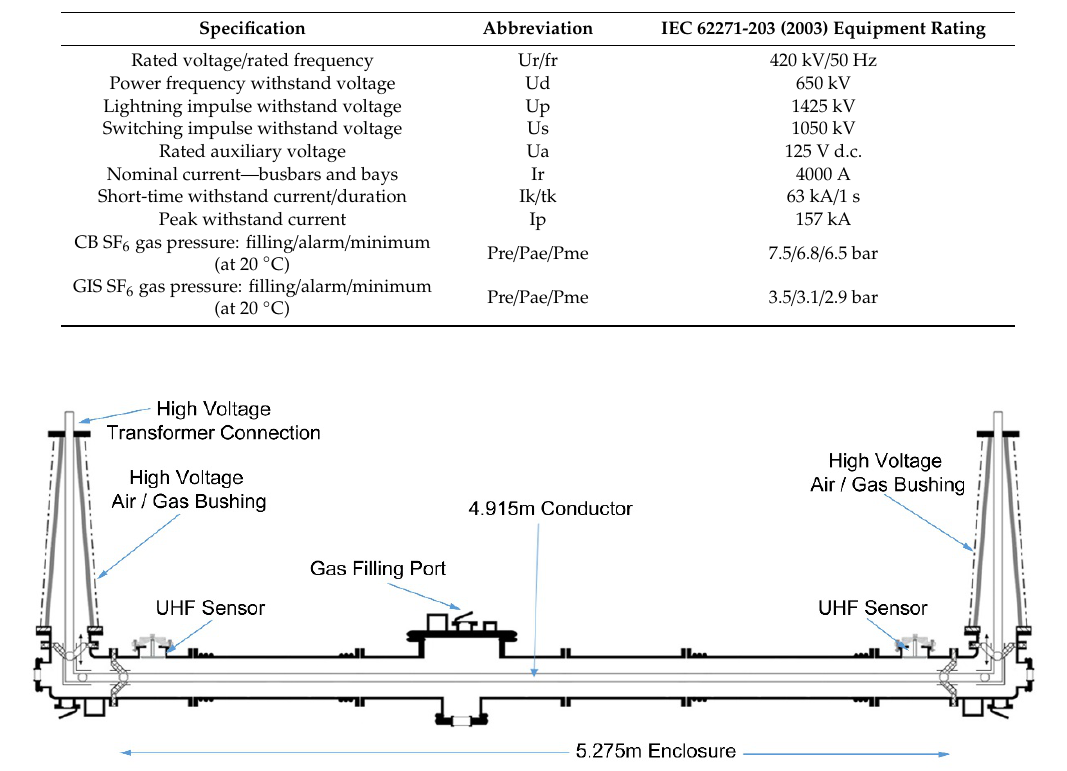
Table 1. Specifications of the gas insulated demonstrator at Cardi ff when filled with pure SF 6 [13].